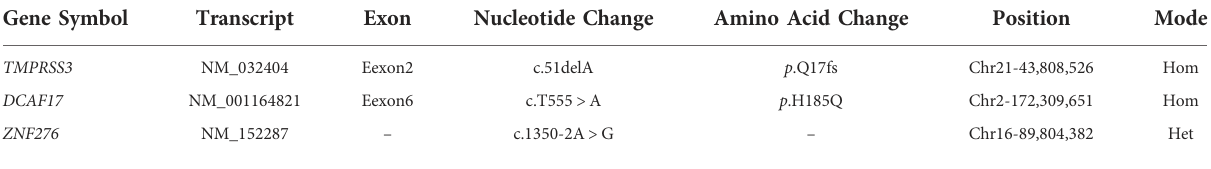
TABLE 2 Candidate genes identi fi ed in the proband with